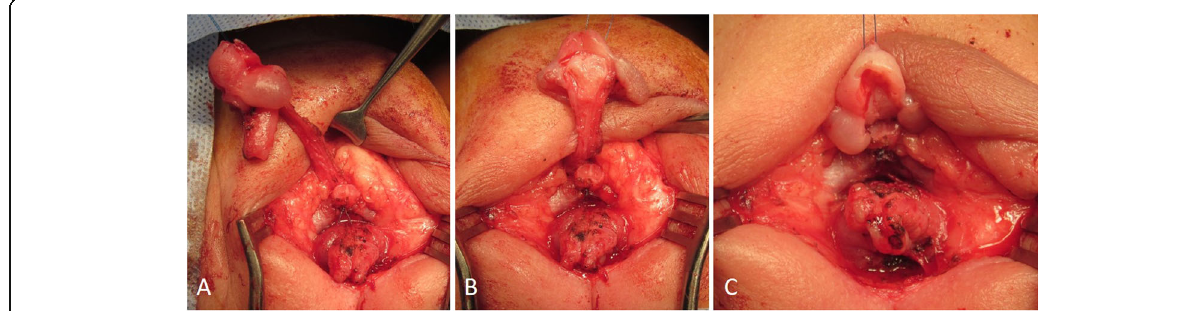
Fig. 5 Feminizing genitoplasty (cont.). A 10-month-old girl with CAH. a , b The glans is preserved in continuity with the dissected dorsal neurovascular bundle. c The glans is then re-sutured to the ligated corporeal